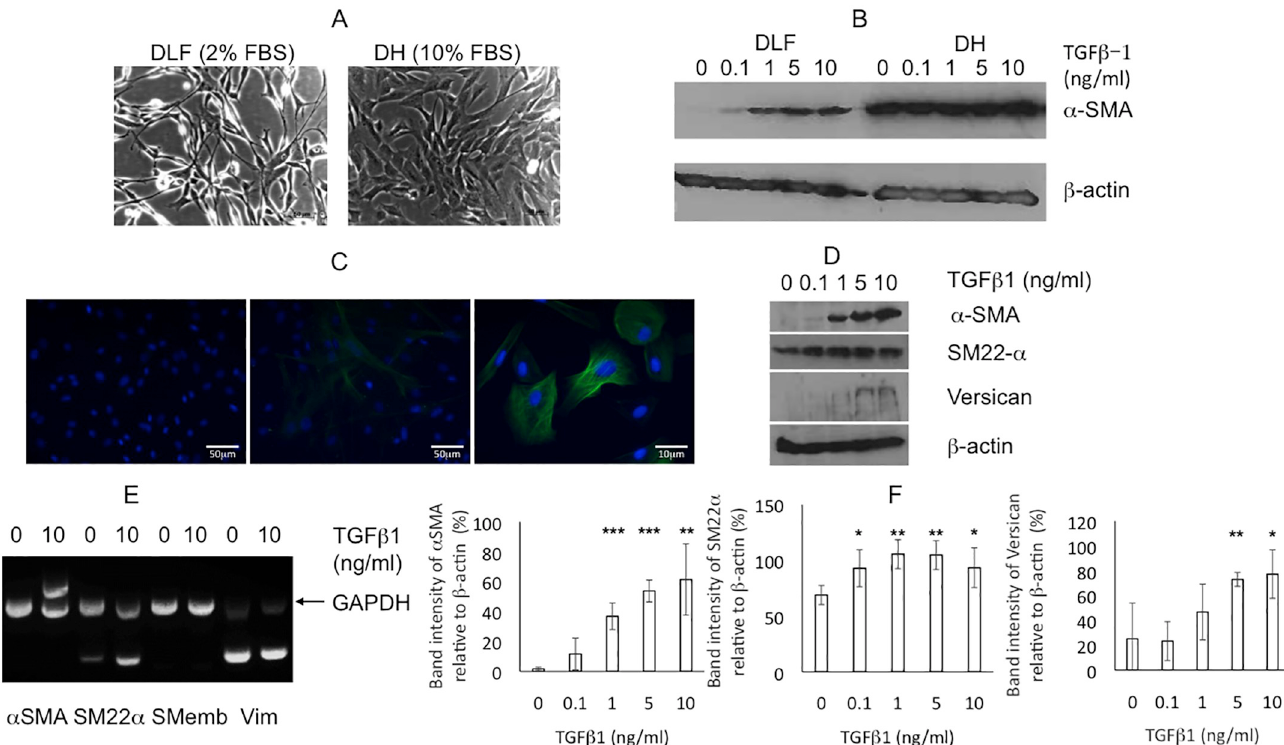
Fig 2. Quiescent valve interstitial cells (VIC) activated by TGF β 1. (A) Representative photomicrographs comparing morphology of normal VICs cultured in 2% (v/v) serum DLF and 10% (v/v) serum DH. Scale bar = 50 μ M. (B) Comparison of the expression of α SMA in low (DLF) and high serum (DH) conditions and in the presence of 0.1, 1, 5 or 10ng/ml TGF β 1. (C) Representative immunofluorescent photomicrographs of increased α SMA (green) expression in normal VICs in DLF (x20 magnification control left panel) treated with 10ng/ml TGF β (x20 and x40 magnification centre and right panel respectively); blue DAPI staining showing cell nuclei. (D) Protein immunoblot for α SMA, SM22 α and versican in DLF. (E) Representative RT-PCR for α SMA, SM22 α , SMemb and vimentin (Vim) (gene specific primers multiplexed PCR with GAPDH housekeeping gene primers) in normal VICs untreated (0ng/ml) or treated (10ng/ml) with TGF β 1 in DLF. (F) Quantification of staining intensities relative to β -actin for α SMA, SM22 α and versican respectively in normal VICs (n = 4) in DLF. Statistical analysis was performed with Student’s t-test. � , �� , ��� P < 0.05, 0.01, 0.001 respectively.